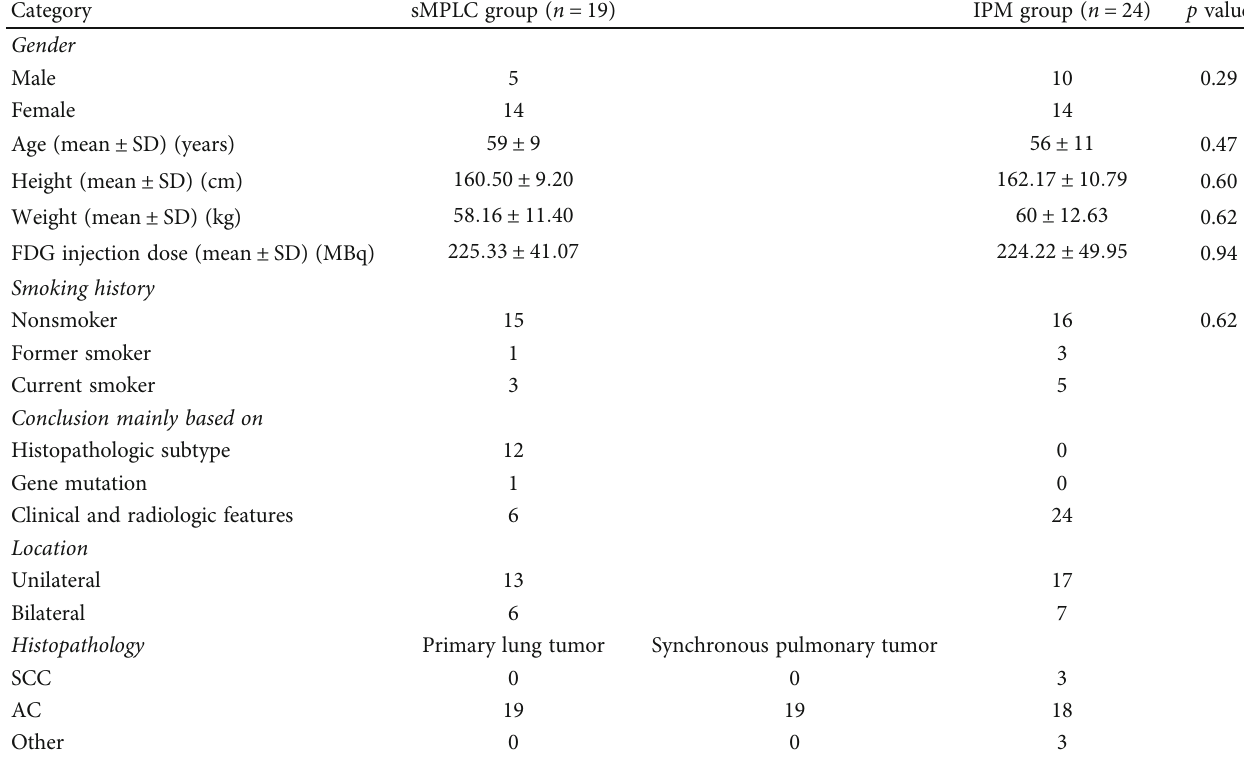
Table 1: Patient and tumor characteristics.